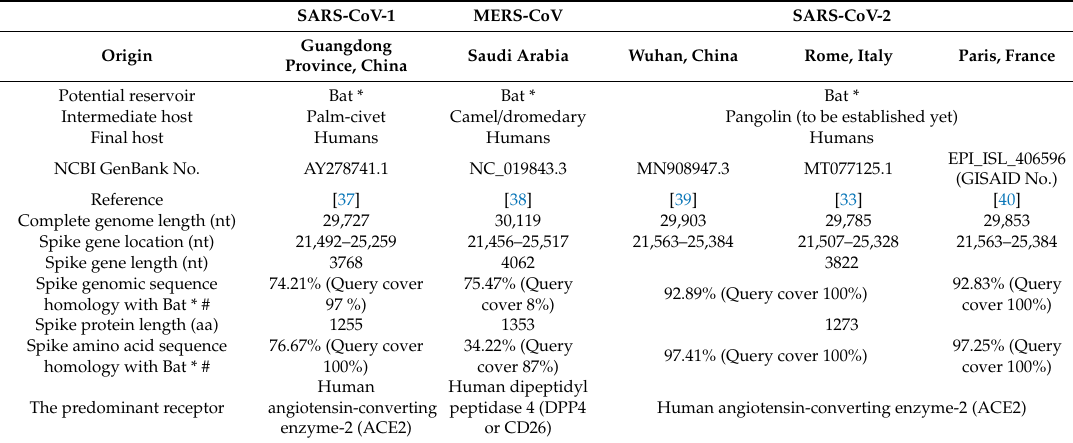
Table 2. Characterization of SARS-CoV-1, Middle Eastern respiratory syndrome (MERS)-CoV, and SARS-CoV-2 spike region, homology with bat coronavirus, and human